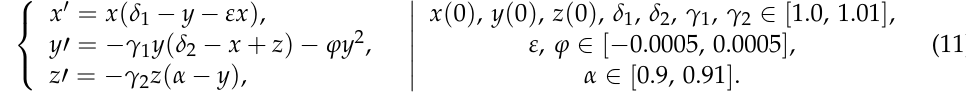
Table 2. Comparison of approaches on system given by Equation (10).